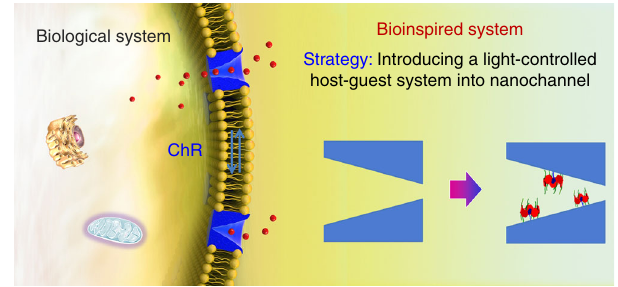
Fig. 1 Schematic of the design of a biomimetic light-activated nanochannel using host – guest systems inspired by ChR channel. The copyright belong to the Shenyang Zhiyan Technology Co., Ltd